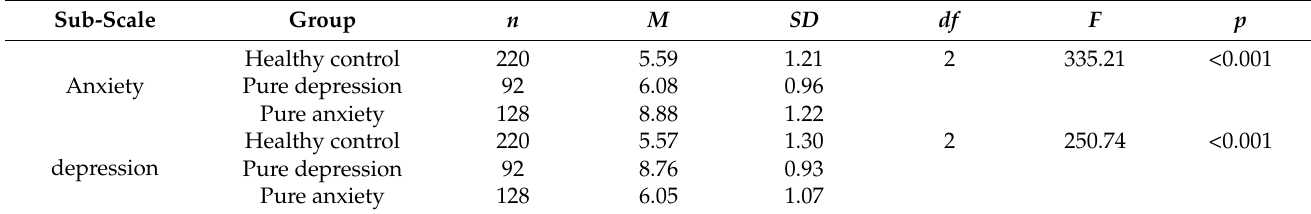
Table 1. Differences in anxiety and depression scores among the three